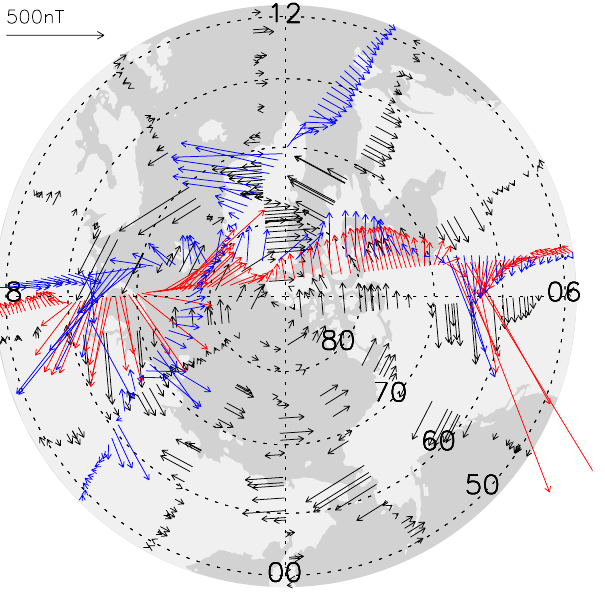
/6 P calculated from the divergence of the electric Fig. 14. J O · E field for 3 October, 2003 as shown in Fig. 11 with J contours over- k layed for comparison. Shaded regions indicate no radar coverage. Note that the colour range differs from Fig. 13 due to the 6 − 1 term. P